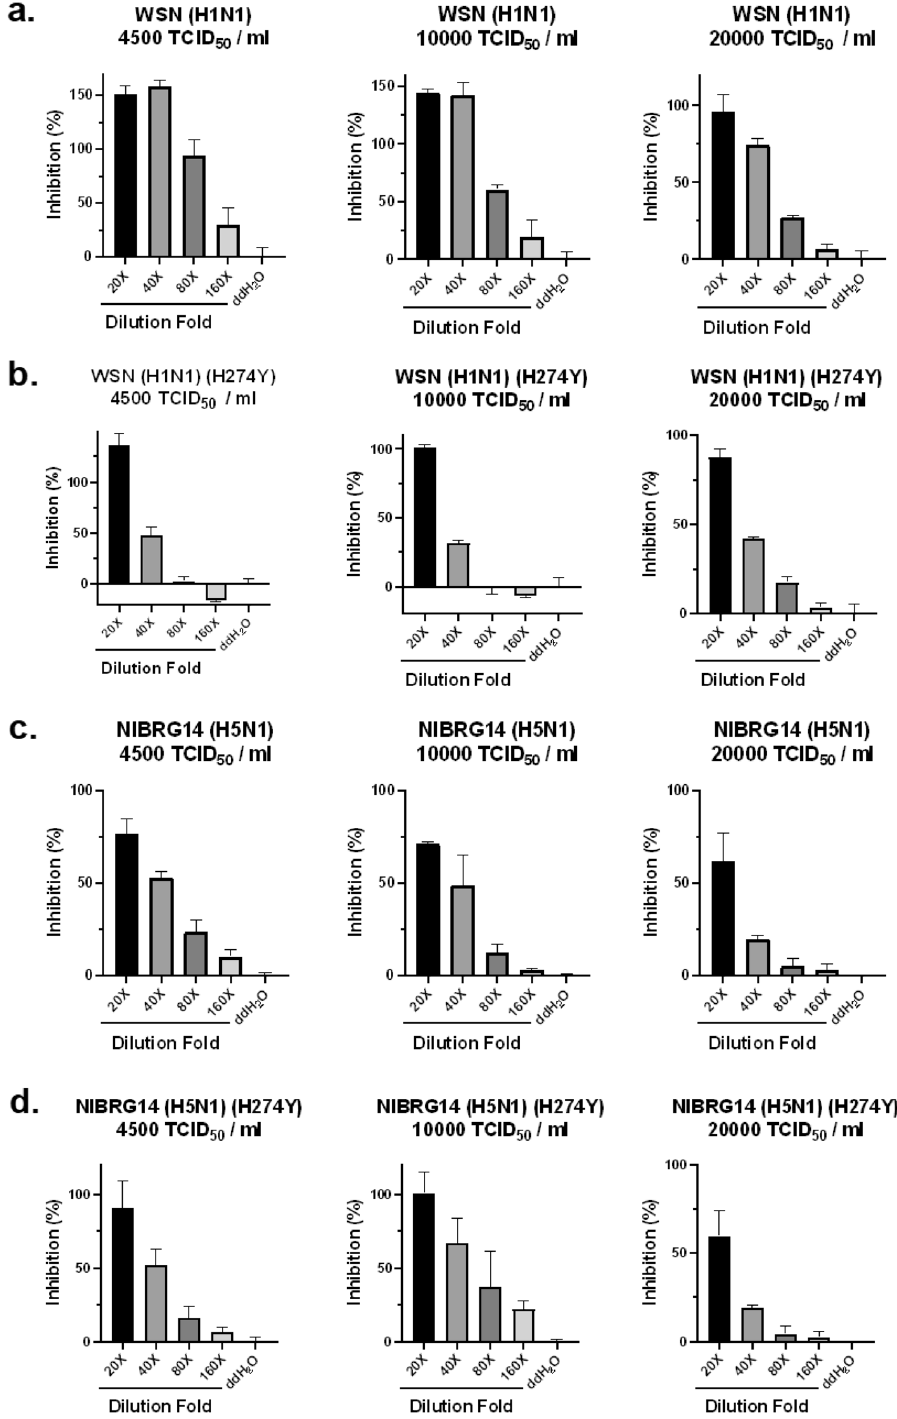
Figure 5. The antiviral activities of TPNT1 against influenza viruses in vitro. MDCK cells were incubated with ( a ) WSN (H1N1), ( b ) oseltamivir-resistant WSN (H1N1)(H274Y), ( c ) NIBRG14 (H5N1), and ( d ) oseltamivir- resistant NIBRG14 (H5N1)(H274Y) at various viral inputs in the presence of TPNT1. After 48 h at 35 °C, the virus-induced cytotoxicity was monitored. The cells incubated with virus only were defined as 0% while the cells with no virus inoculation were defined as 100%